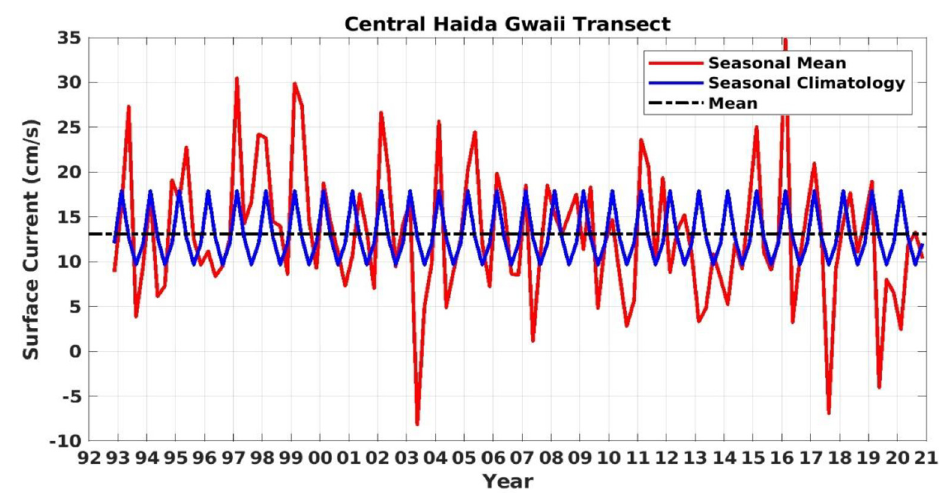
Figure 7. Same as Figure 3 but at the Central Haida Gwaii Transect.